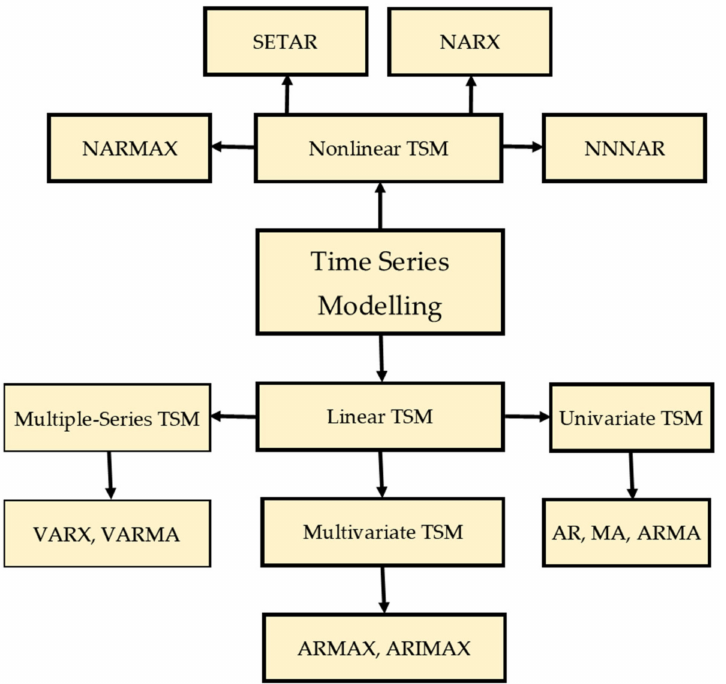
Figure 1. Classification of time series models. TSM, time series model; AR, autoregressive; MA, mov- ing average; ARMA, autoregressive moving average; ARMAX, autoregressive moving average with exogenous variables; ARIMAX, autoregressive integrated moving average with exogenous variables; VARX, vector autoregressive with exogenous variables; VARMA, vector autoregressive moving aver- age; NARX, nonlinear autoregressive with exogenous variables; NARMAX, nonlinear autoregressive moving average with exogenous variables; SETAR, self-exciting threshold autoregressive; NNNAR, neural network nonlinear